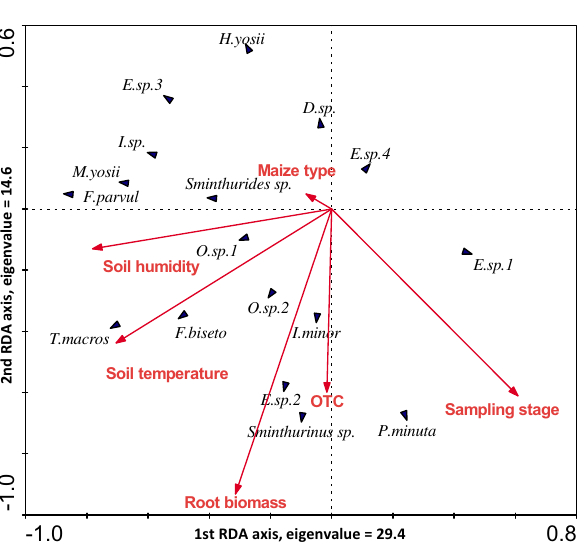
Figure 2. Soil collembolan abundance ( A ), species richness ( B ), Shannon–Wiener index ( C ), and Pielou’s evenness index ( D ) of the different experimental treatment plots at different sampling stages, analyzed using one-way analysis of variance (ANOVA).